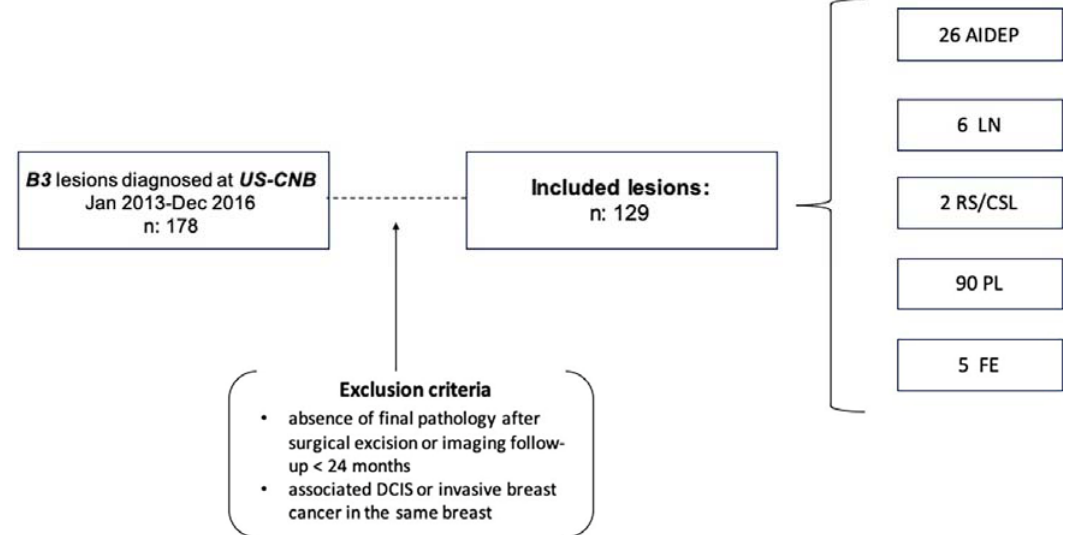
Figure 1. Study outline and final lesions analyzed. US ‐ CNB: ultrasound ‐ guided core needle biopsy. DCIS: ductal carcinomas in situ, AIDEP: atypical intraductal epithelial proliferation, LN: lobular neoplasia, RS/CSL: radial scar/complex sclerosing lesions, PL: papillary lesions, FE: fibro ‐ epithelial lesions with cellular stroma.